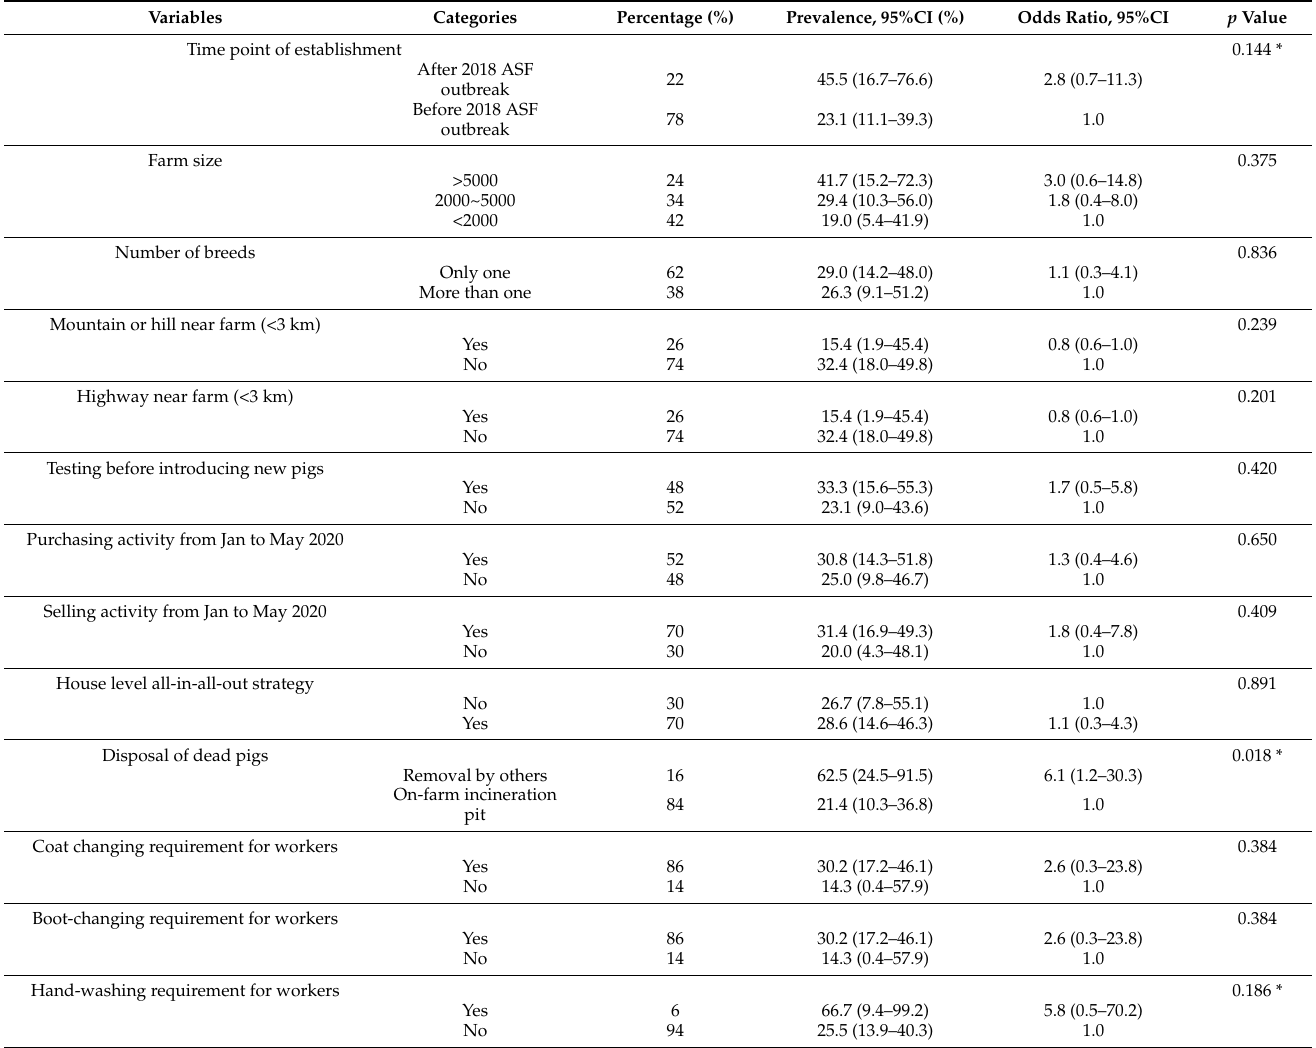
Table 2. Univariable analyses of the variables that have potential risks to farm level viral disease